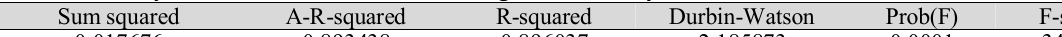
The summary of some basic statistics on regression analysis between two Sortino methods